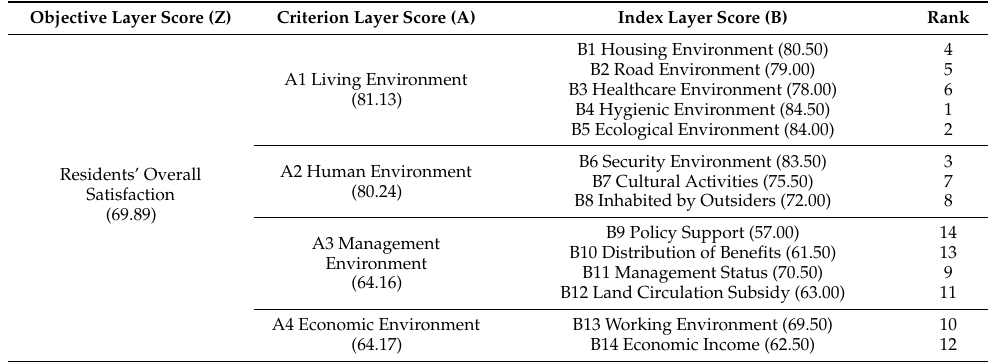
Table 4. Residents’ satisfaction scores with multi-dimensional environments in Doushan